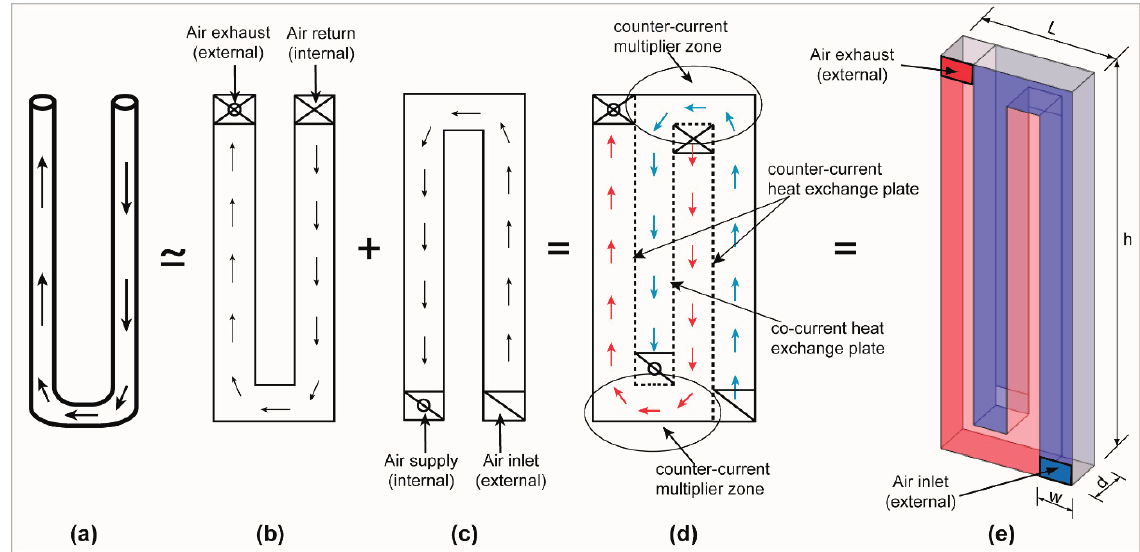
Figure 2. Schematic evolution of the system showing transition from ( a ) simple